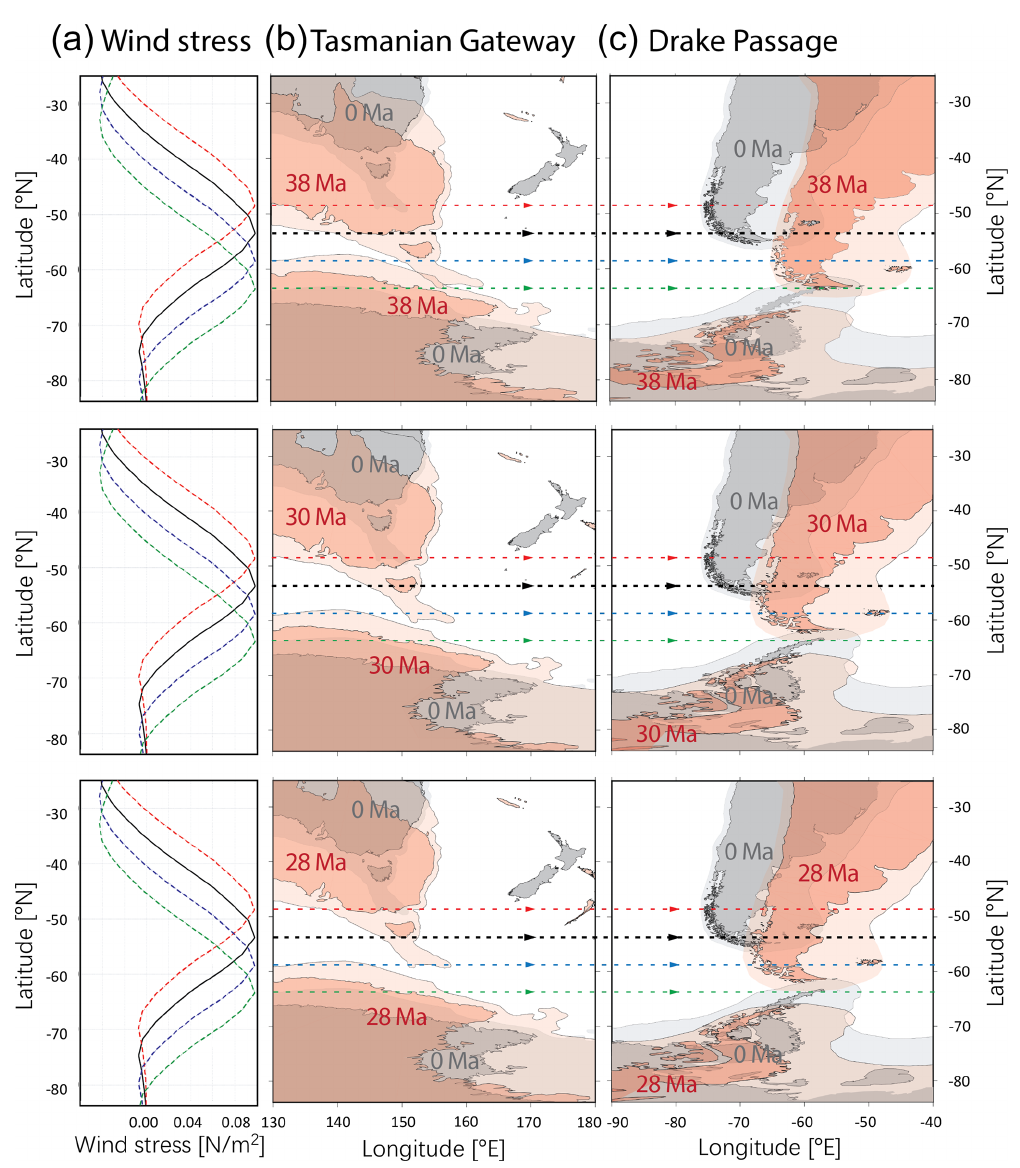
Figure 1. (a) Zonal mean wind stresses used in all simulations. The black curve (max 53 ◦ S) is the revised version from Sauermilch et al. (2021). The maximum westerly of max 53 ◦ S has a strength of about 0.1Nm − 2 and is located at about 53 ◦ S. Red (max 48 ◦ S), blue (max 58 ◦ S) and green (max 63 ◦ S) curves indicate the shifts of the max 53 ◦ S curve 5 ◦ to the north, 5 ◦ to the south and 10 ◦ to the south, respectively. Relative positions of continents (at 38, 30, 28Ma, and present day) versus peak wind stresses for (b) the Tasmania Gateway and (c) the Drake Passage. Coloured dashed lines in (b) and (c) show latitudinal positions of the maximum westerly in four wind stress conditions. Dark orange and grey areas show paleo-continental and modern continental coastlines, respectively. Light orange and light grey areas represent paleo and modern continent-ocean-boundary, respectively. These reconstructions use the rotation model by Matthews et al. (2016) with the paleomagnetic reference frame (van Hinsbergen et al.,